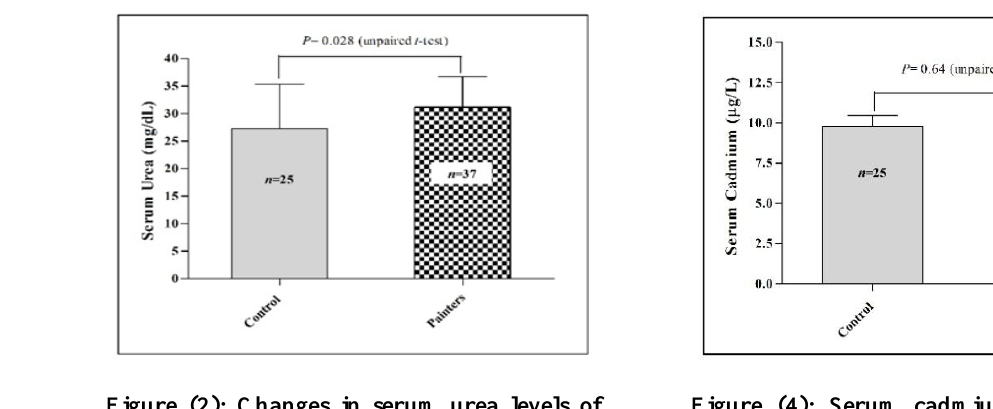
Figure (4): Serum cadmium (Cd) levels of painting workers in Sulaimani city. n : number of subjects; P >0.05: non-significant difference compared with control group .